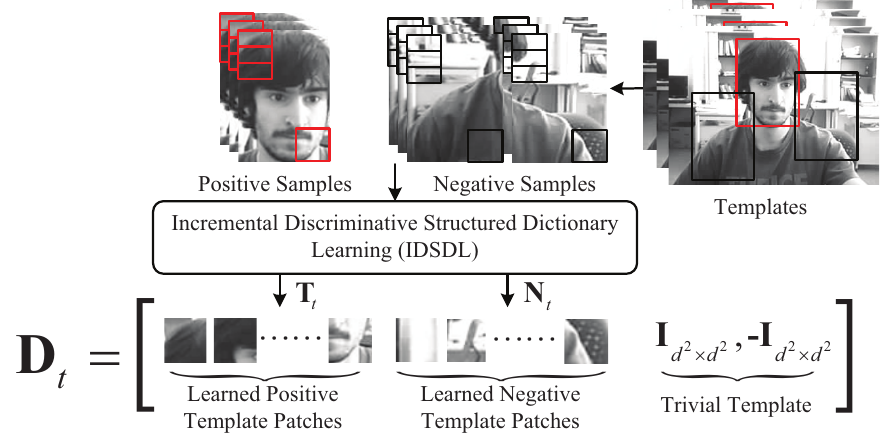
Figure 2. Generation of proposed dictionary, which is composed of positive and negative template patches learned by IDSDL and trivial templates. The corresponding patches are cropped separately from the positive and negative samples around the target based on different sampling